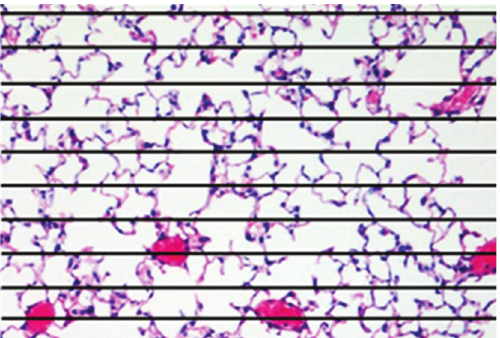
Figure 1: Calculation of the mean linear intercept ( L m ). A transparent sheet with 10 equally distributed horizontal lines is laid over the printed digitized image of an H&E-stained section. A transparent sheet with 11 equally distributed vertical lines is used thereafter (not shown). For each line, the intercepts with the tissue structures are counted. L m is calculated as the ratio between the product of the number of times the traverses are placed on the lung and the length of the traverses, and the sum of all the intercepts.